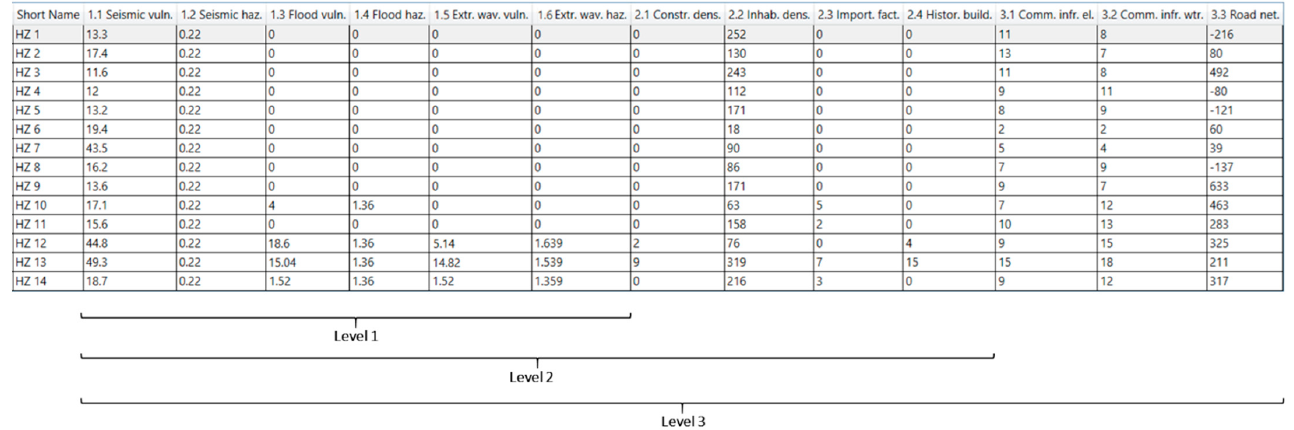
Figure 19. Input matrix for combined seismic–flood–extreme waves risk (Scenario S-F-EW) multi- criteria analysis with criteria evaluation for all three levels.